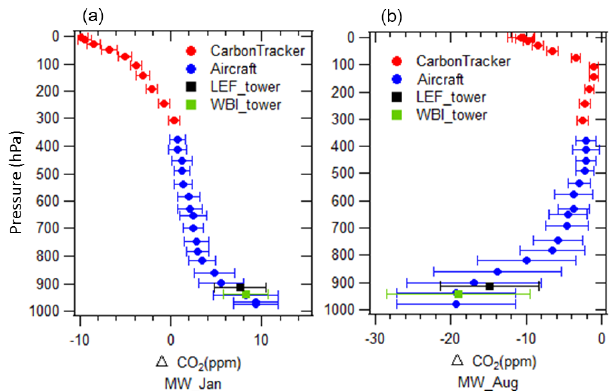
Figure 5. Long-term mean (2004–2014) average vertical profiles in January (a) and August (b) in MW. The error bar shows 1 standard